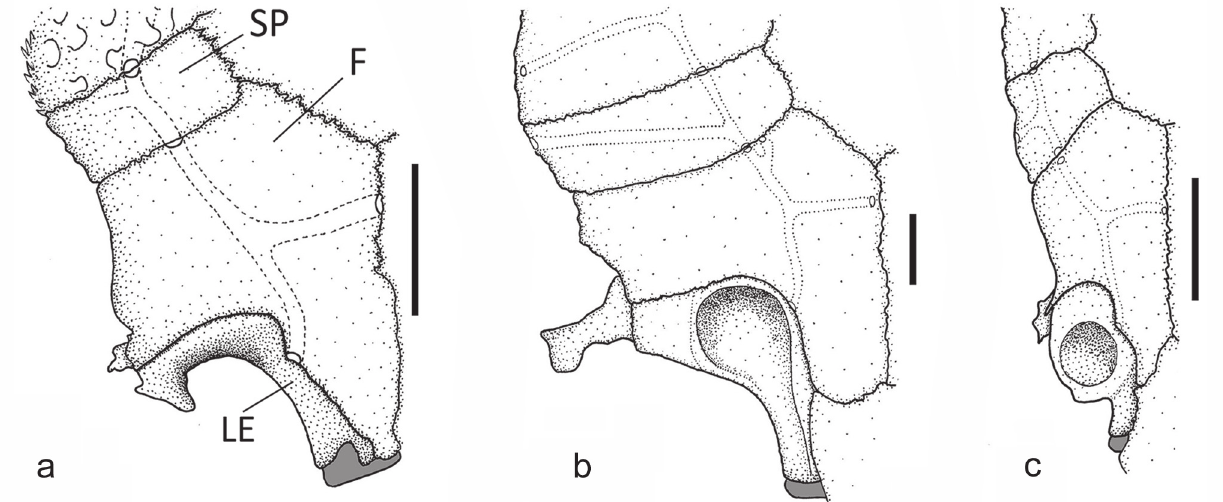
Fig. 2. Central portion of neurocranium of: a) Otocinclus batmani , MCP 34087; b) Hypoptopoma inexspectatum , MCP 15744; and c) Acestridium martini , MZUSP 74275. F = frontal; LE = lateral ethmoid; SP = sphenotic. Dorsal view, anterior towards bottom. Scale bar = 1 mm